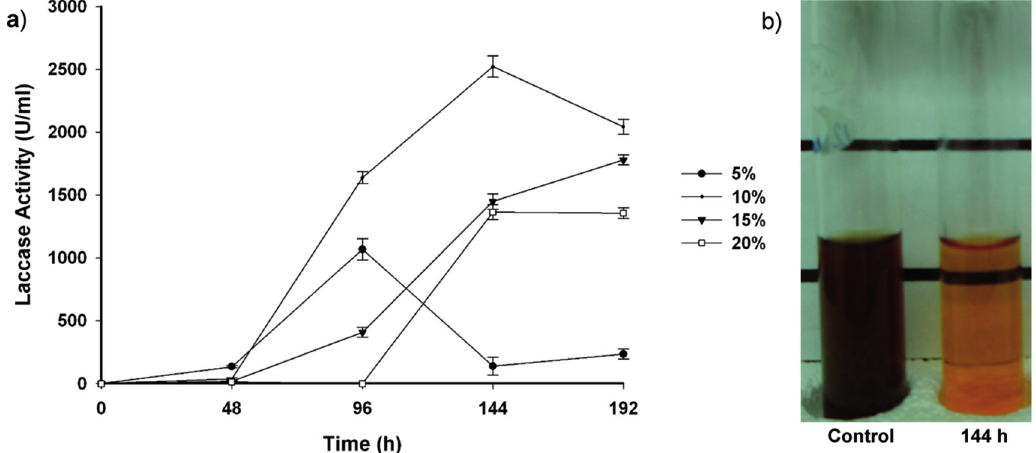
Figure 4. ( a ) Laccase activity of T. hirsuta Bm-2 over eight days of cultivation in different vinasse concentrations; ( b ) Discoloration of 10% ( v / v ) vinasse by T. hirsuta Bm-2 at 144 h of cultivation. Results were represented as means ± standard deviation of three parallel measurements ( n =